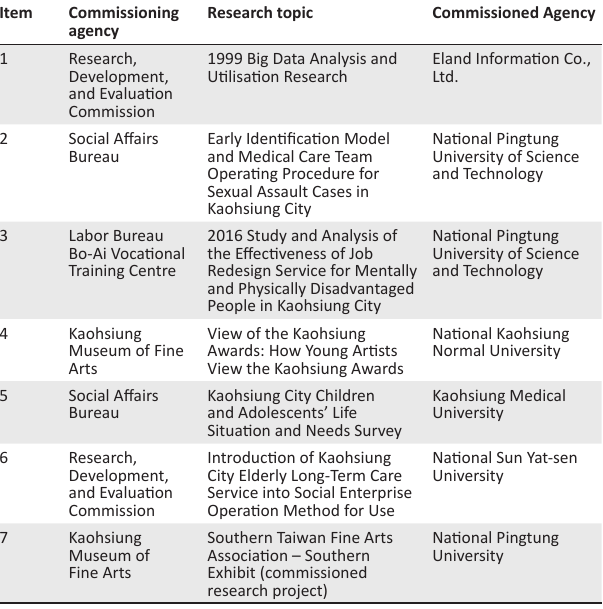
TABLE 3 : Kaohsiung City Government agencies outsourced research cases in